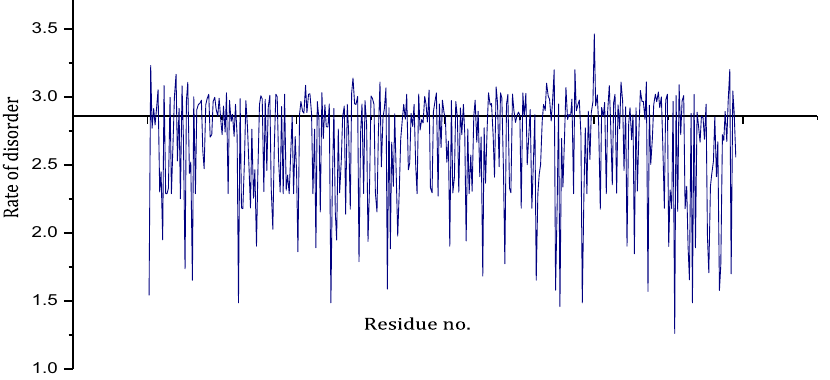
Figure 1. The changing rate of Shannon entropic score of the protein members from synuclein protein family (Pfam id.